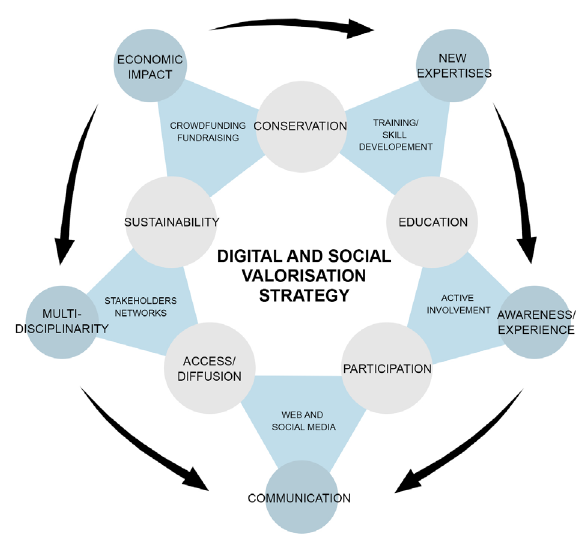
Figure 7 . the criteria founded in Chapter 2.4 highlight their interactions and the areas of